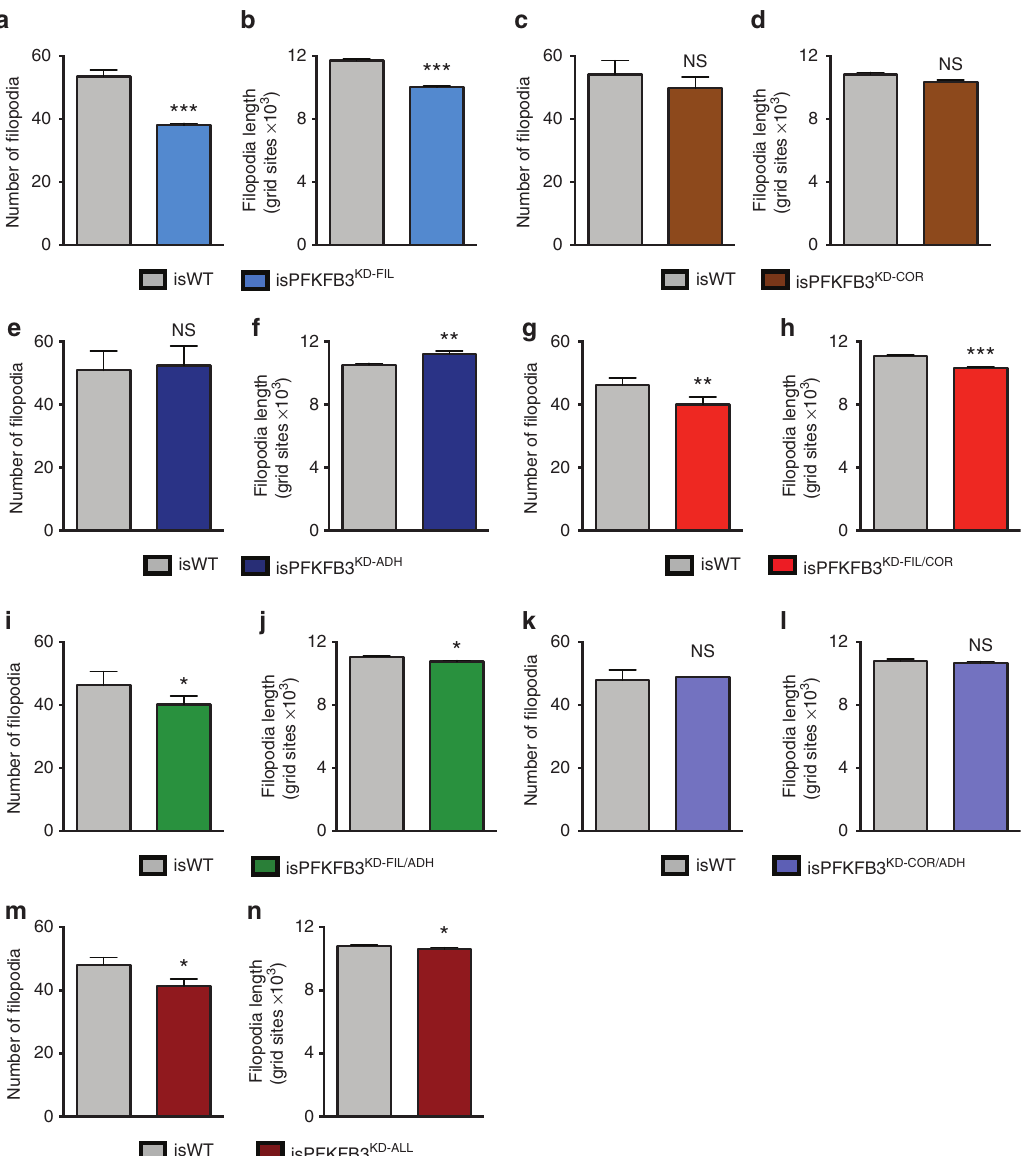
Figure 3 | E FIL -containing isPFKFB3 KD mechanisms have reduced filopodia. ( a-n ) Number and length of filopodia for in silico WT (isWT) and in silico PFKFB3 KD (isPFKFB3 KD ) cells, modelled by modifying the single mechanisms E FIL ( a , b ), E COR ( c , d ) and E ADH ( e , f ), and the combinatorial mechanisms E FIL/COR ( g , h ), E FIL/ADH ( i , j ), E COR/ADH ( k , l ) and E ALL ( m , n ). Data are mean ± s.e.m.; n ¼ 4–5; NS, not significant, * P o 0.05, ** P o 0.01, *** P o 0.001; Student’s t- (Supplementary Fig. 1). Overall, the MSM-ATP predicted that PFKFB3-driven glycolysis affects vessel sprouting through effects on filopodia formation, alone or together with cortical protrusion formation or adhesion.